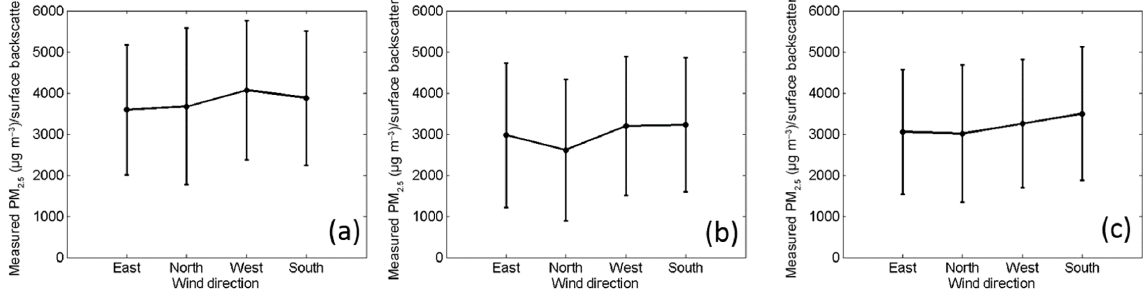
Figure 7. Average PM2.5/backscatter ratio with standard deviation at four direction ranges – east (315 to 45 ◦ ), north (45 to 135 ◦ ), west (135 to 225 ◦ ) and south (225 to 315 ◦ ) – for (a) daytime clear cases, (b) daytime cloudy cases and (c) nighttime